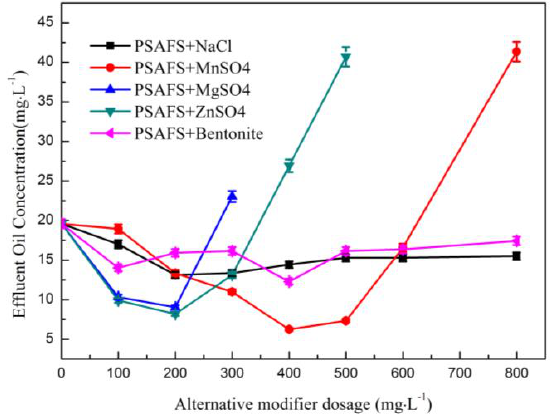
Figure 2. Influence of addition of alternative modifiers on deoiling effect of PSAFS.